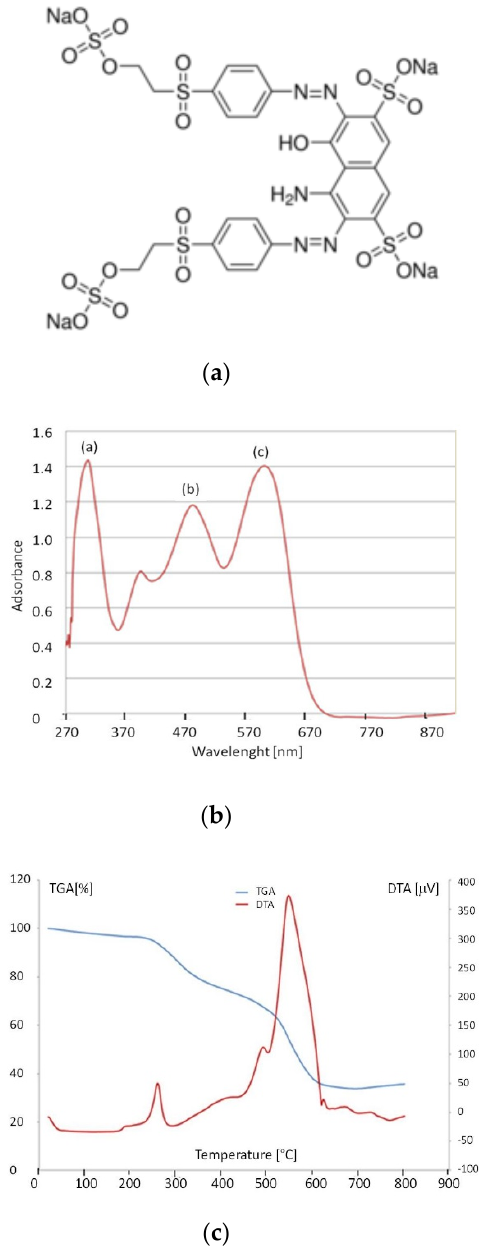
Figure 3. ( a ) Structural formula; ( b ) UV-visible spectrum; ( c ) TGA and DTA curves of Reactive Black-5 dye.